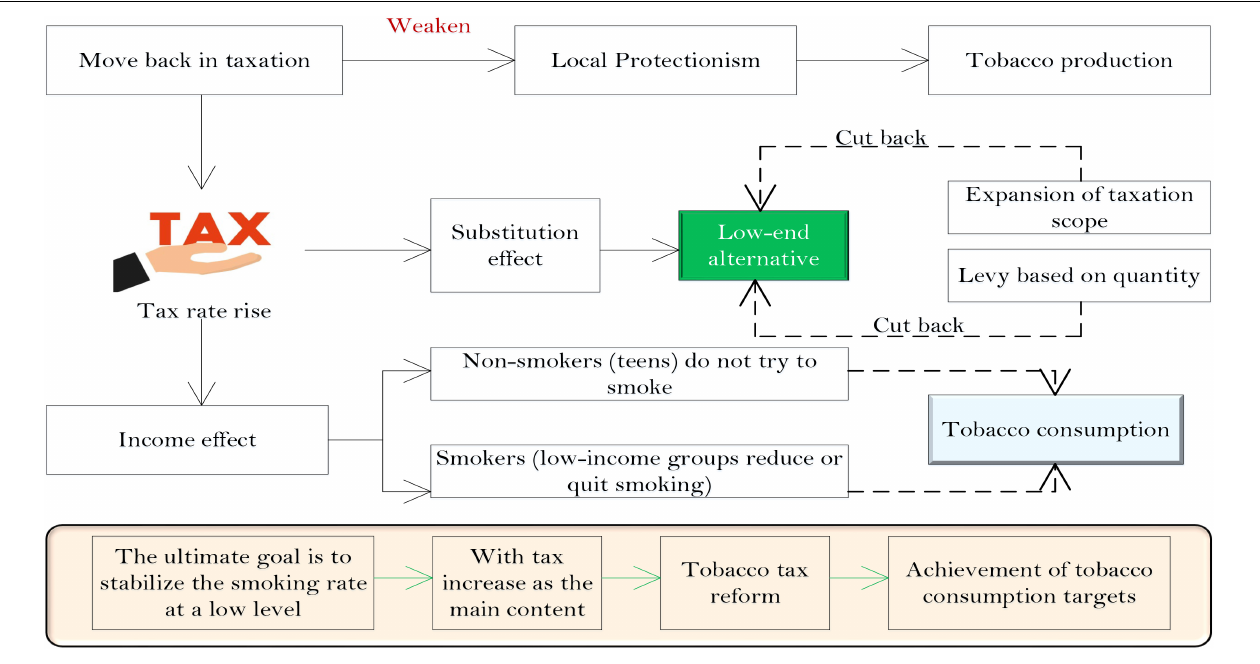
FIGURE 3 | Optimization framework of tobacco consumption tax